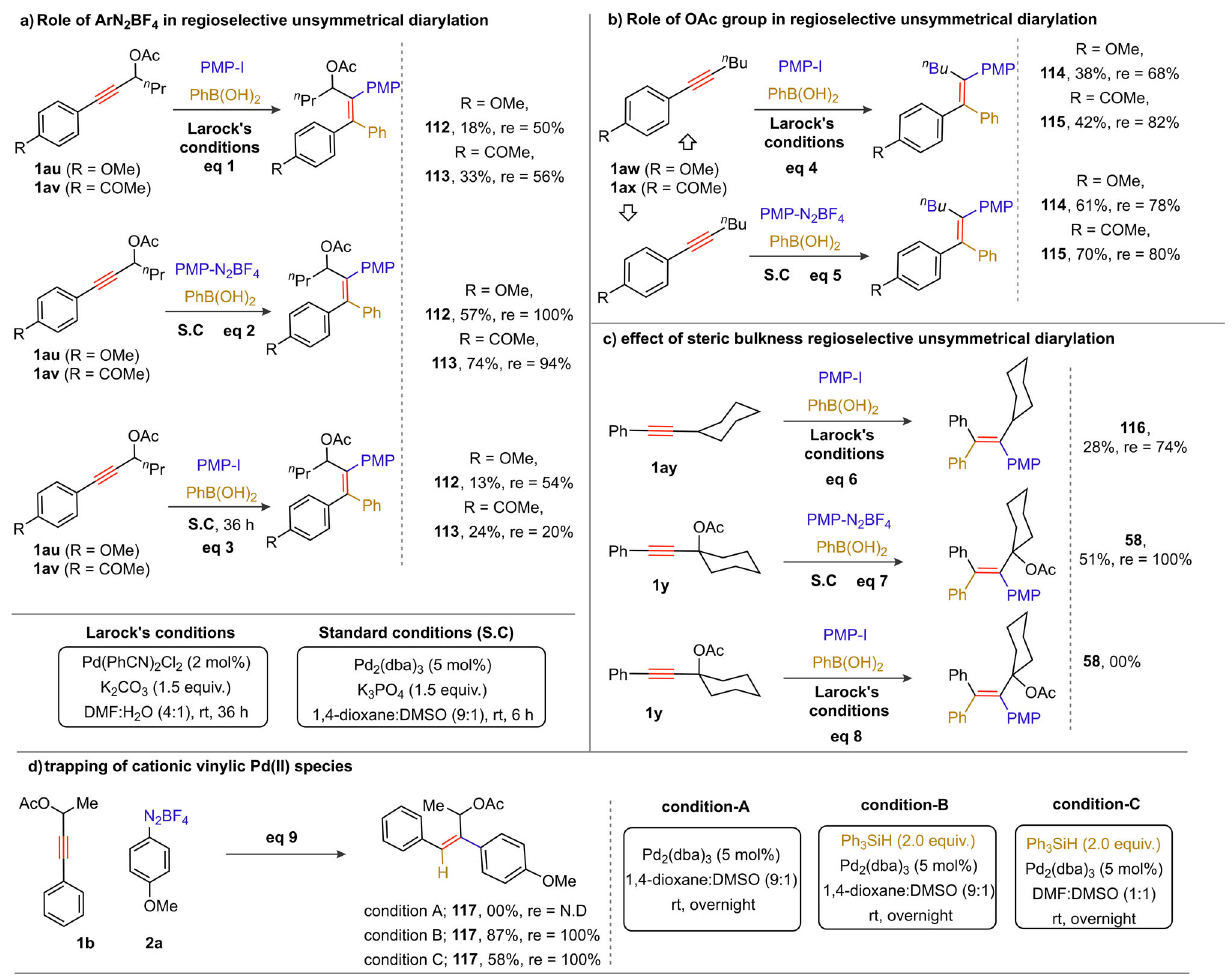
Fig. 6 Mechanistic studies. a Three comparative reactions were performed with electronically diverse propargyl acetates under the {Larock ’ s reaction conditions: eq 1 [PMP-I, PhB(OH) 2 , Pd(PhCN) 2 Cl 2 , K 2 CO 3 , DMF:H 2 O (4:1), rt]}, {standard conditions (SC) of current reaction: eq 2 [PMP-N 2 BF 4 , PhB(OH) 2 , Pd 2 (dba) 3 , K 3 PO 4 , 1,4-dioxane:DMSO (9:1), rt]}, and {SC of current reaction: eq 3 [PMP-I instead of PMP-N 2 BF 4 ]}. Excellent